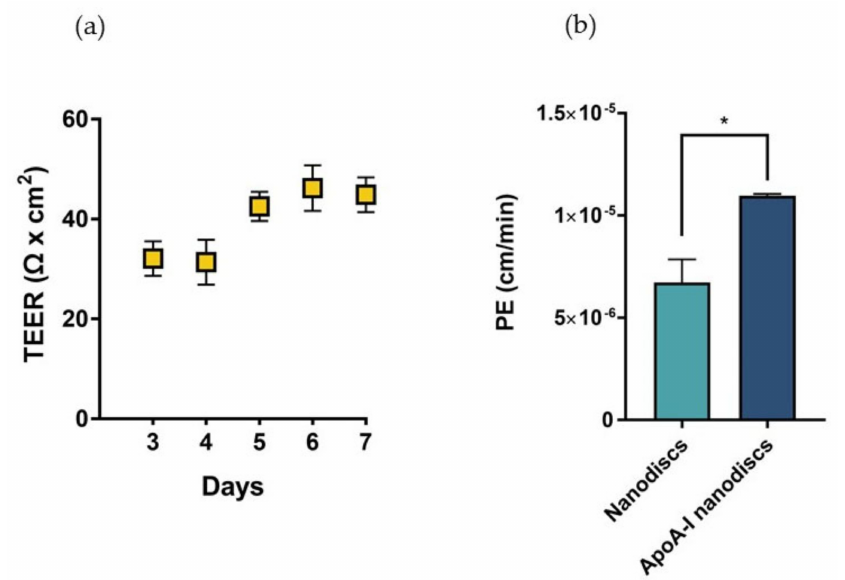
Figure 10. Characterization of the BBB in vitro model and evaluation of the passage of nanodiscs. ( a ) TEER values of the cell monolayer from day 3 to day 7 of growth on transwell reaching a maximum value of 44 Ω × cm 2 on the seventh day of growth. ( b ) Evaluation of the passage of fluorescently labelled nanodiscs and apoA-I nanodiscs; * p <0.05 (Student’s t